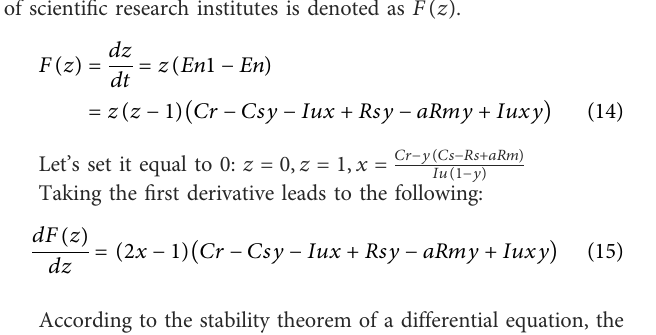
(cid:6)(cid:6)(cid:6)(cid:6) > 0, x (cid:2) 0 means that no matter the value (whether LBM is produced or not), the game is stable, and SM building material manufacturers will get the same income. time, y (cid:2) 0 is a stable state, SM building material manufacturers tend to produce HBM. time, y (cid:2) 1 is a stable state, SM building material manufacturers tend to produce LBM.